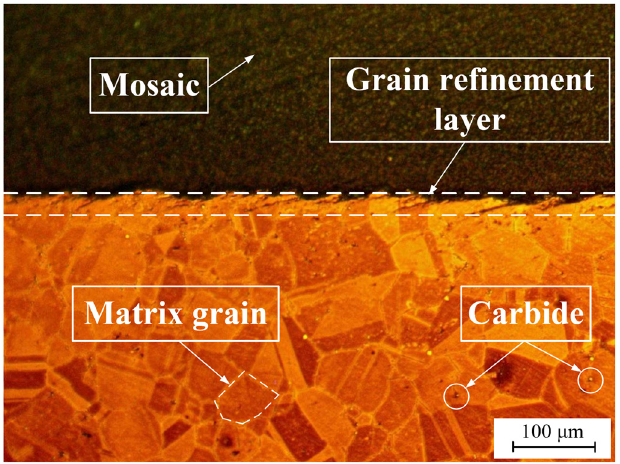
Figure 11. Metallographic structure of the GH4169 workpiece cross-section.